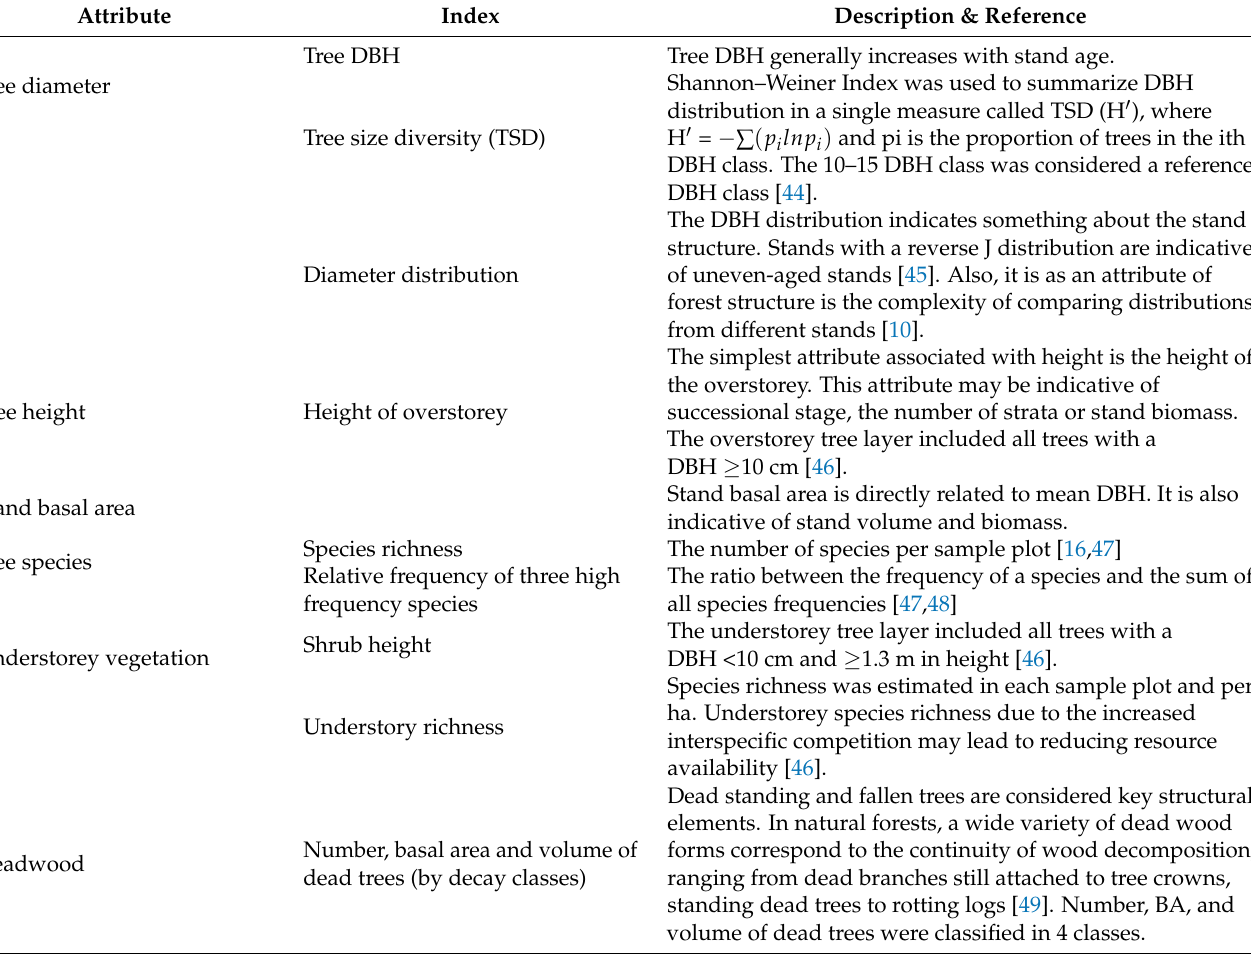
Table 1. Description of attribute studied in the presence and pseudo-absence